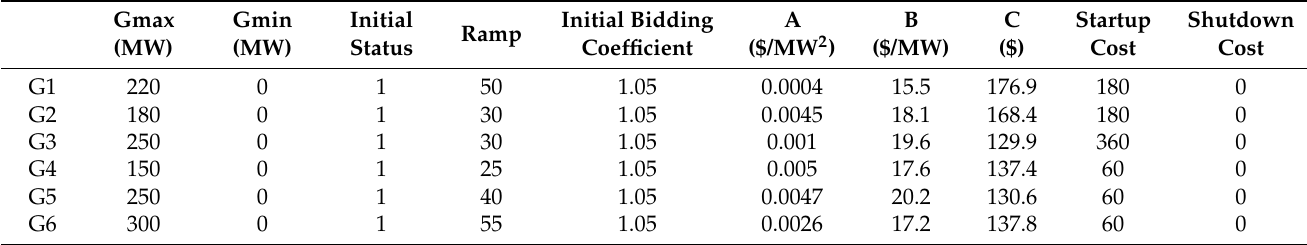
Table A5. Bidding parameters of power producers in the 33-bus